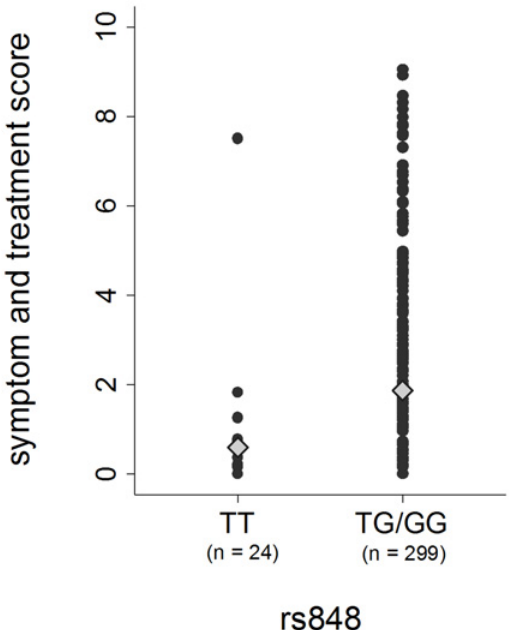
Fig 4. Distribution of the symptom and treatment score among the cases of asthma, according to their genotype in SNP rs848 in the IL13 gene region. The genotype is coded according to the dominant genetic model (the homozygous genotype with the lower allele frequency is the reference). Diamonds represent the expected scores, adjusted for gender, BMI and smoking habits. (cid:129) after adjusting for multiple testing, polymorphisms in other gene regions show a non-signifi- cant moderate association with symptom severity or lung function only.